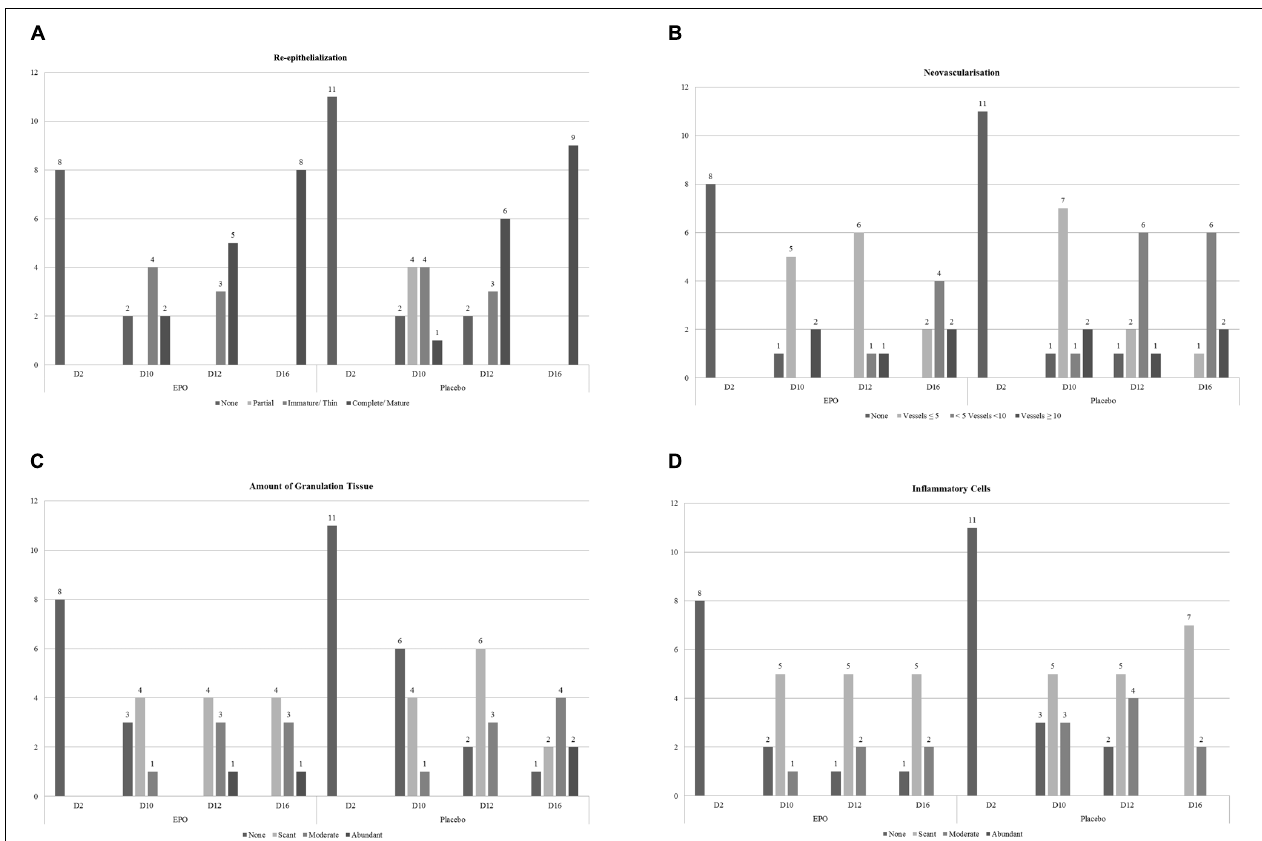
FIGURE 2 | Wound healing evaluation scale. Legend: We analyzed histology’s in 21 patients (EPO: 10, Placebo: 11), but 2 EPO patients had too many missing biopsies, so we excluded them from analysis. The bars show absolute patient numbers. The histologic features were assessed by the same specialist (blinded to the treatment) in paraffin-embedded sections using hematoxylin/eosin stains under light microscopy at a magnification of 5X to 10X. Histological wound evaluation scoring included: (A) re-epithelialization (0 = none; 1 = partial; 2 = complete, but immature/thin; 3 = complete and mature), (B) neovascularization (0 = none; 1 = up to 5 vessels/high-powered magnification field [HMF]; 2 = 6–10 vessels/HMF; 3 = > 10 vessels/HMF), (C) amount of granulation tissue (0 = none; 1 = scant; 2 = moderate; 3 = abundant), and (D) inflammatory cells (0 = none; 1 = scant; 2 = moderate; 3 = abundant). The scoring system was modified from Sevimli-Gür et al.